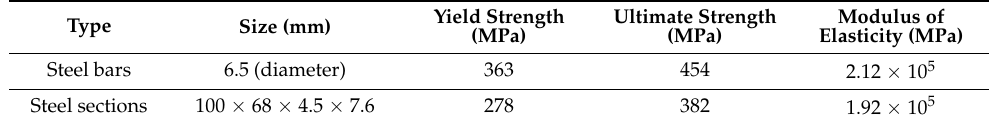
Table 1. Property parameters of the steel bars and steel sections.